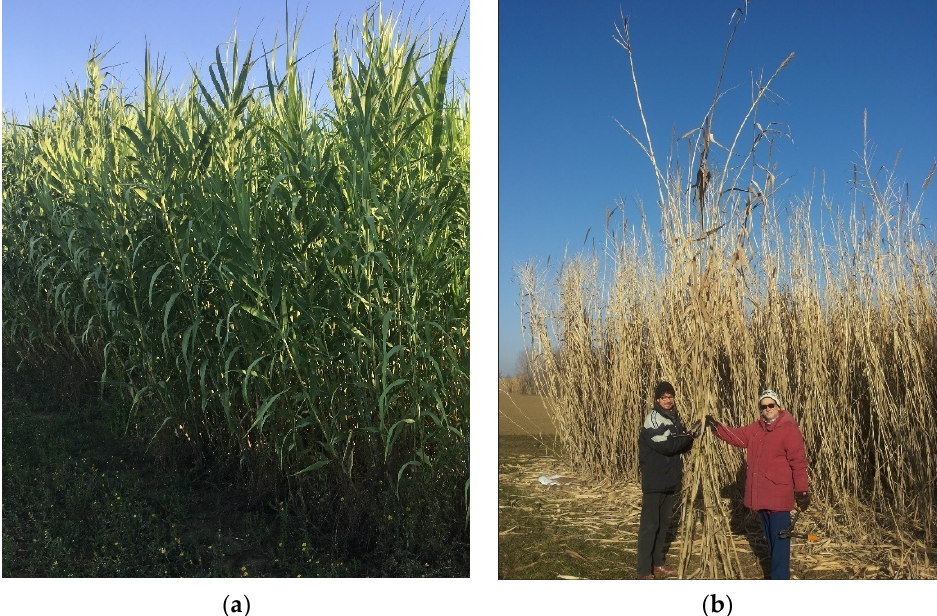
Figure 1. ( a ) Giant reed plants at the growing stage; ( b ) plants at the end of the growth cycle. Pictures were taken at the experimental farms of the Council for Agricultural Research and Economics (CREA), Anzola dell’Emilia, Bologna, northern Italy (courtesy of Enrico Ceotto). Table 2. Composition of the giant reed meal used in the experiments as reported in a previous paper [15] 1 . Standard deviations (sd) are reported in brackets ( n = 3). Composition